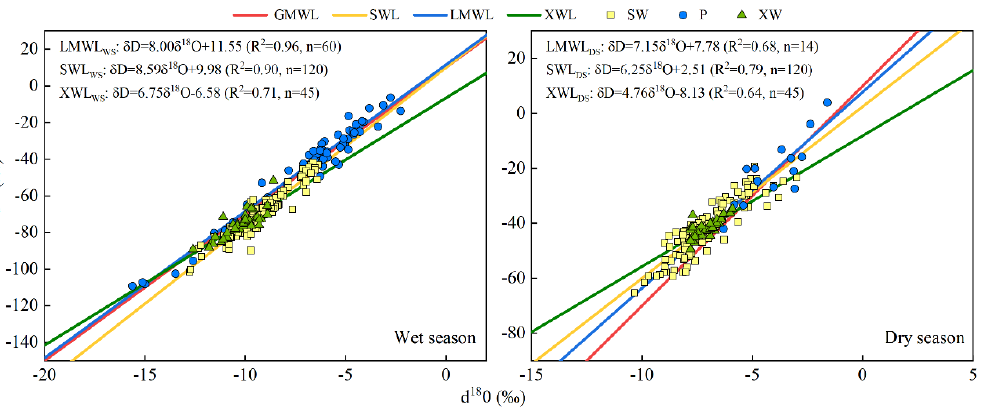
Figure 6. Linear regression relationship of δ D and δ 18 O in rainfall, soil water and xylem water from wet season and dry season.